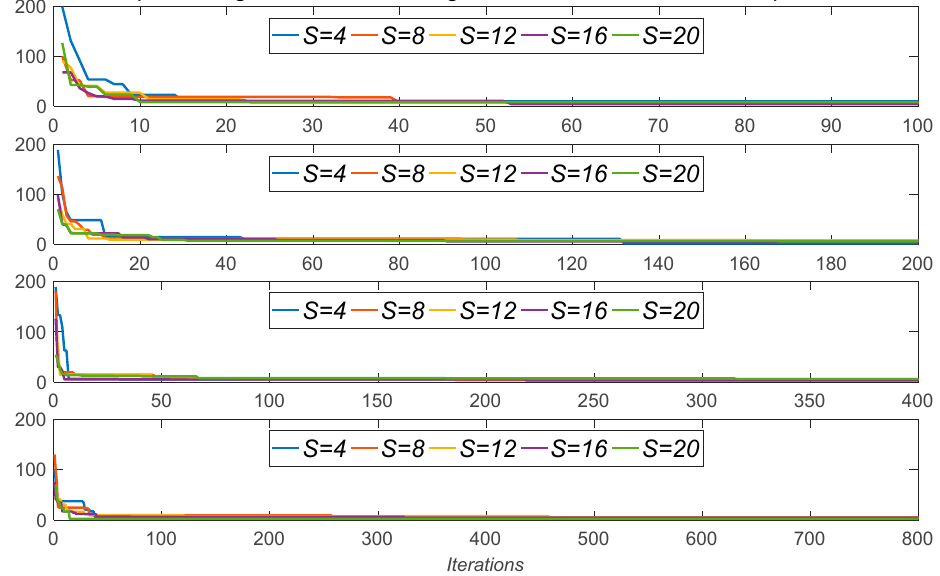
Figure 9. The optimal segmentation matching calculation with different EC parameters.